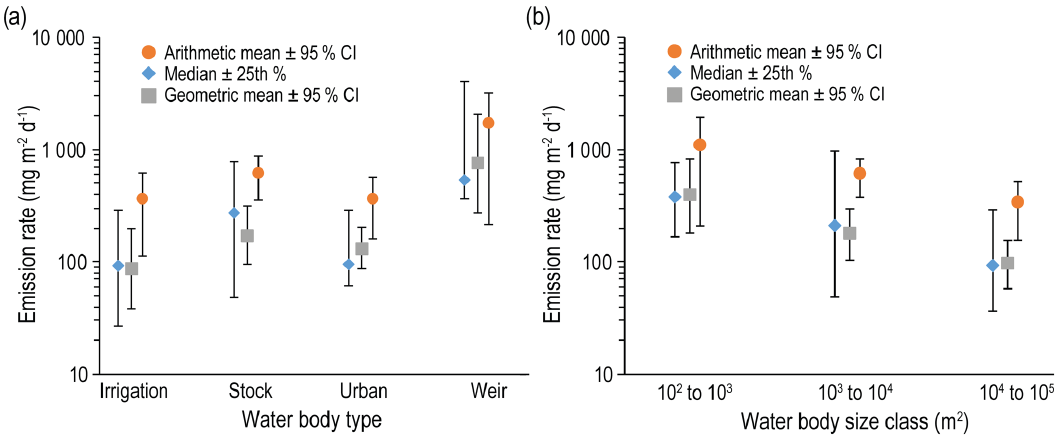
Figure A6. Three measures of centrality for methane emissions across (a) four categories of small water bodies (irrigation dams, stock dams, urban lakes and weirs) and (b) three GRanD water body size classes. Errors for each measure are as follows: median emission rates and interquartile range ( ± 25th%), arithmetic and geometric mean emission rates and 95% confidence intervals ( ± 95%